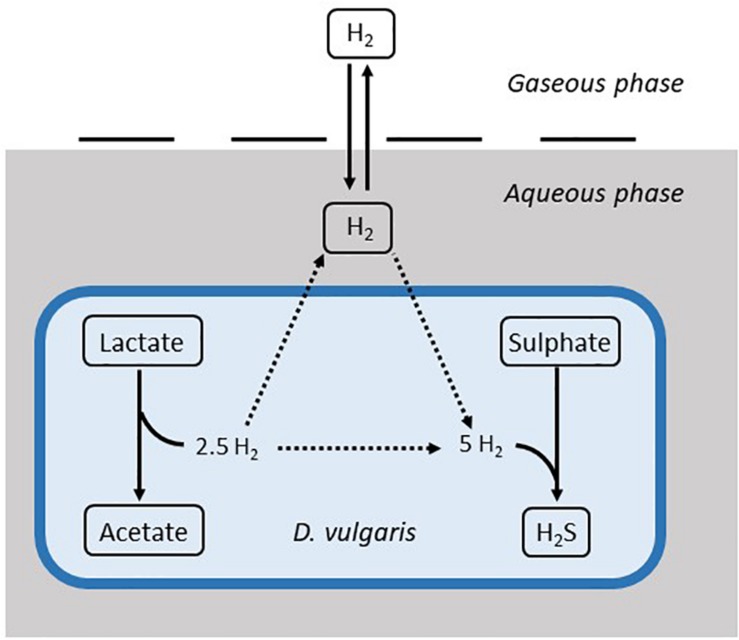
Structure of the mathematical model. Solid arrows denote modelled dynamics. Dotted arrows denote dynamics that are not explicitly modelled. H2S: hydrogen sulphide.